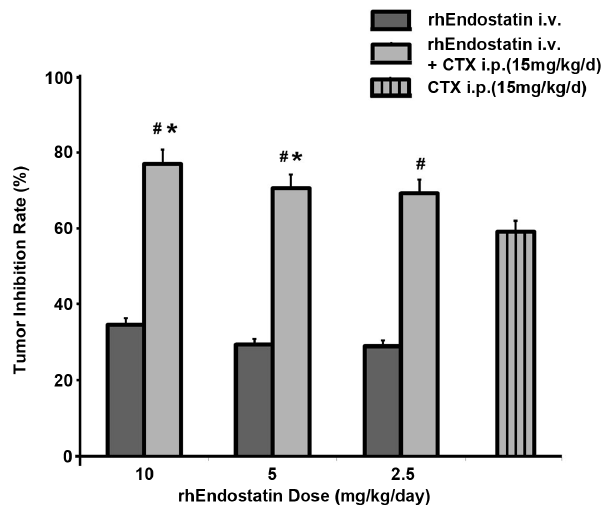
Figure 7. Additive inhibition effect of rhEndostatin with DDP on the growth of A549 lung cancer. Nude mice (n=10, each) were inoculated with 6 6 10 6 tumor cells subcutanously to establish the tumor-bearing model. The animals were either administered peritumo- rally with rhEndostatin alone at 5 mg/kg/day, 10 mg/kg/day, and 15 mg/kg/day for 15 days, successively, or combined with DDP treatment at 3 mg/kg/d every other day for 15 days. The tumor volume was measured every other day, and the formula, [(tumor volume of control-tumor volume of treatment)/tumor volume of control] 6 100%, was used to calculate the inhibition rate of tumor growth. # : P , 0.05 vs mice administered with single rhEndostatin treatment at the same dose, respectively; *: P , 0.05 vs mice treated with DDP alone at 3 mg/ kg/day.